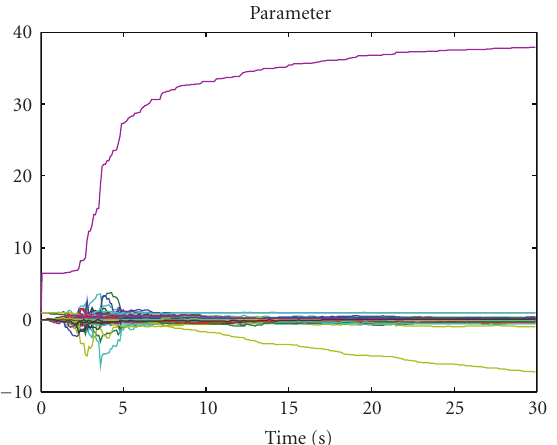
Figure 8: Convergence of parameter estimation of NARMAX model using RELS method without